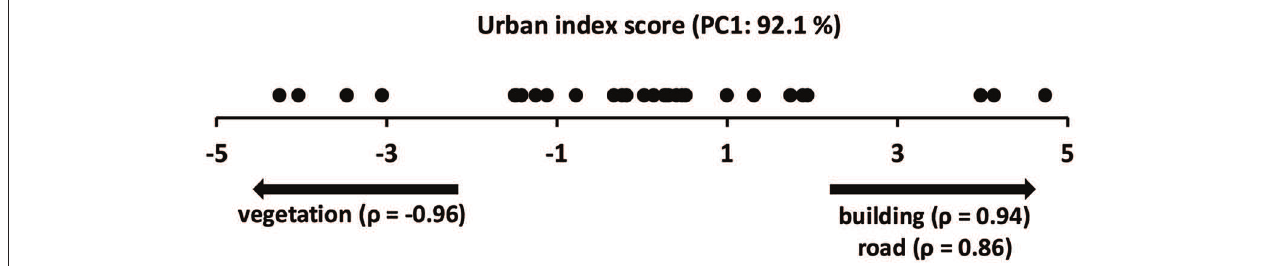
FIGURE 2 | Distribution of the urban sites along the first axis of the PCA based on the urbanization index scores. Spearman rank correlation values between the urbanization index variables and site scores are shown below the axis.